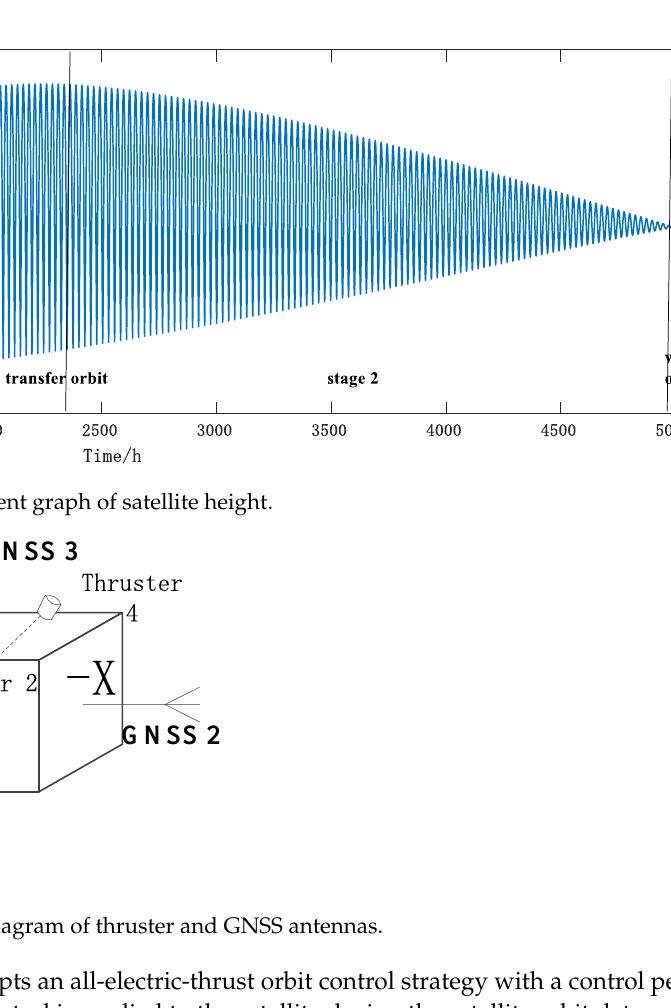
Figure 2. Installation diagram of thruster and GNSS antennas.